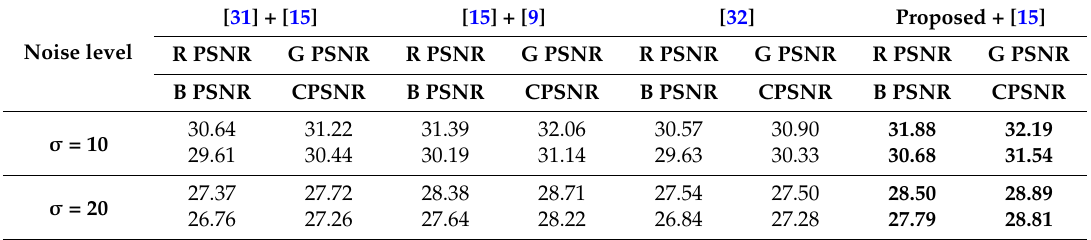
Table 2. Average PSNR(dB) comparisons for the denoised and color interpolated results of Calendar